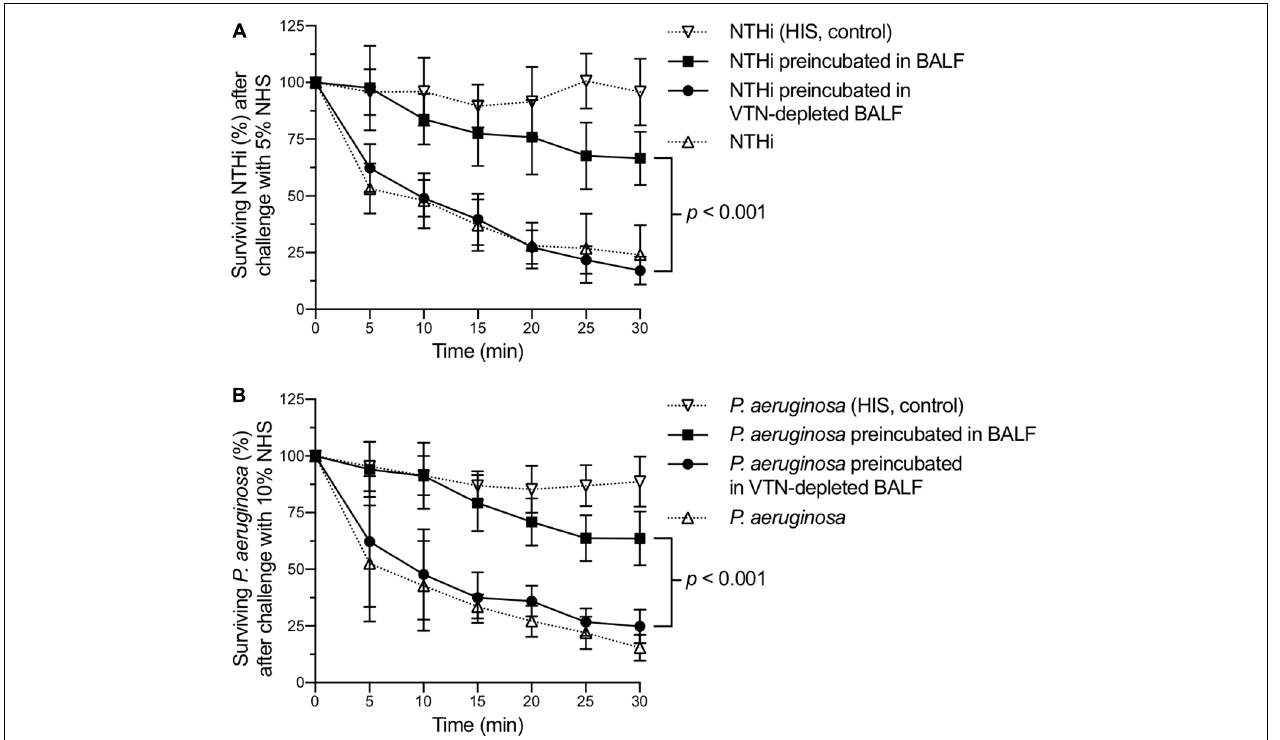
FIGURE 4 | Bacterial respiratory pathogens use vitronectin to evade killing by complement. Nontypeable H. influenzae (A) and P. aeruginosa (B) were challenged with normal human serum after preincubation in BALF from pneumonia patients (solid squares) or in vitronectin (VTN)-depleted BALF (solid circles). Bacteria incubated with heat-inactivated serum (HIS) (inverted open triangles) and untreated bacteria (open triangles) were used as controls. Mean values and standard deviations of three biological replicates are shown. Variations between the preincubated groups were analyzed by two-way ANOVA and are presented as p